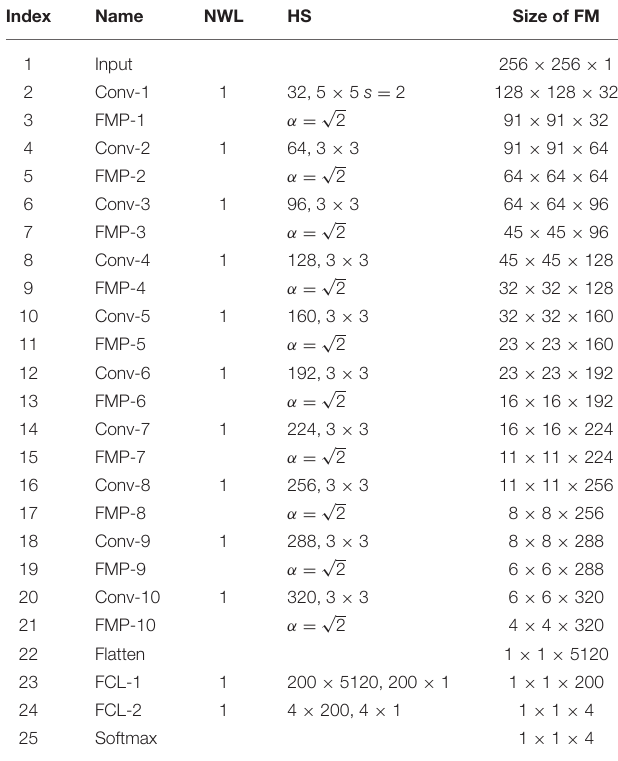
TABLE 3 | Structure of proposed 12-layer